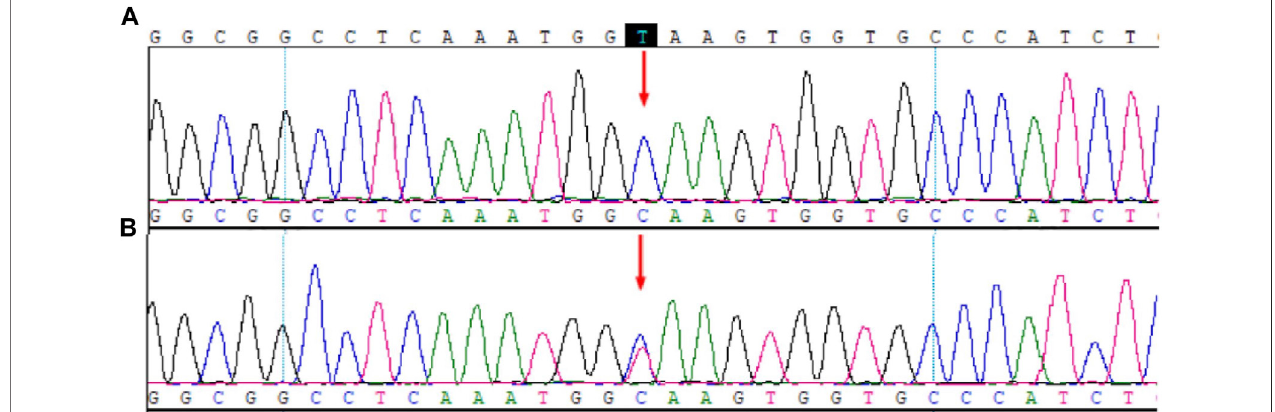
FIGURE 1 | Mutation sites in CYP17A1 . (A) Patient. (B) Father.